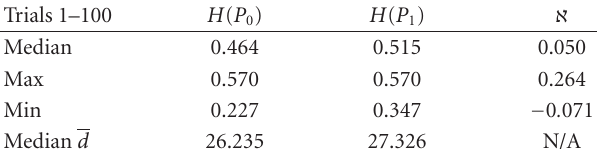
Table 1: Descriptive statistics of model results on trials